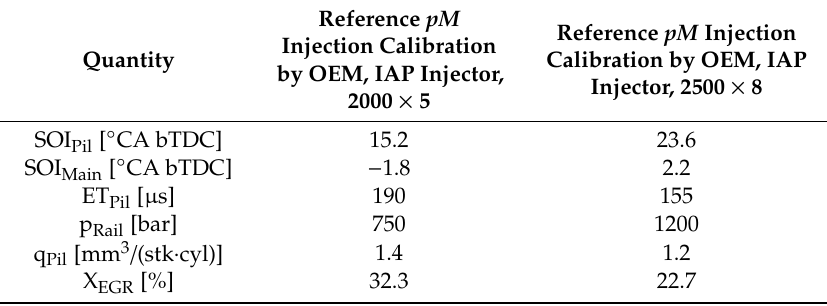
Table 5. Main parameters of the reference pM calibration at 2000 × 5 and 2500 × 8, with IAP